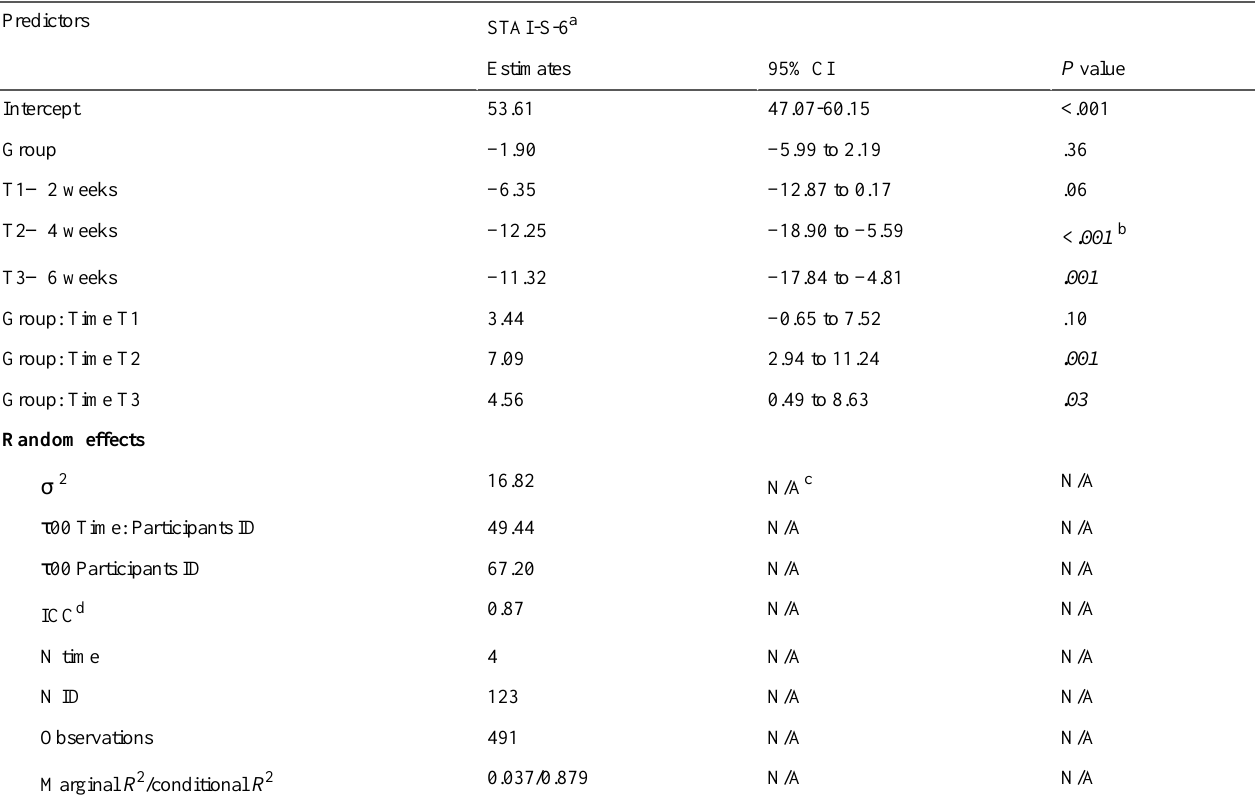
Table 2. Summary of the linear-mixed model on State-Trait Anxiety Inventory scores over the 4 time points in the intervention and waitlist control groups.